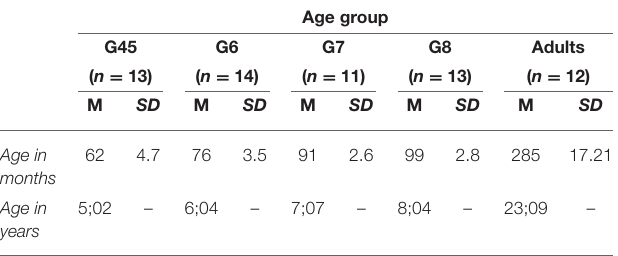
TABLE 2 | Mean age (in months and years) for different groups of